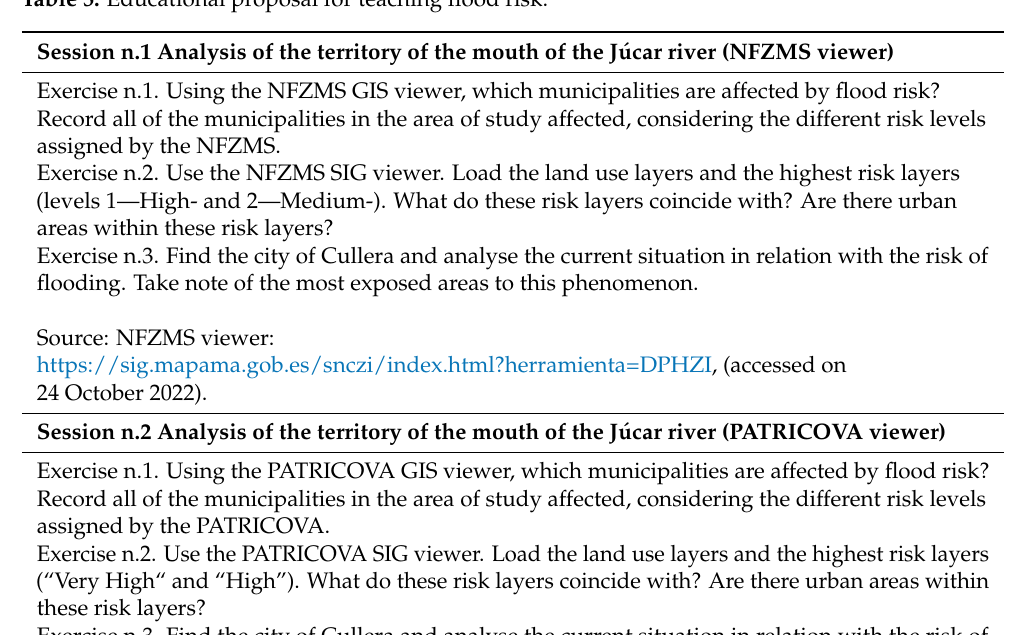
Table 5. Educational proposal for teaching flood